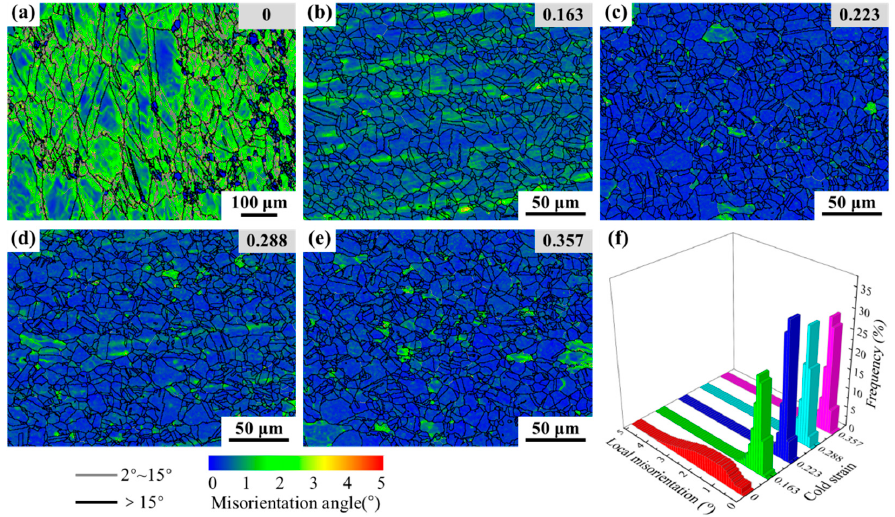
Figure 7. KAM maps ( a – e ) and local intragranular misorientation distributions ( f ) after two-stage deformation with different prior cold strains and the same thermal deformation condition.